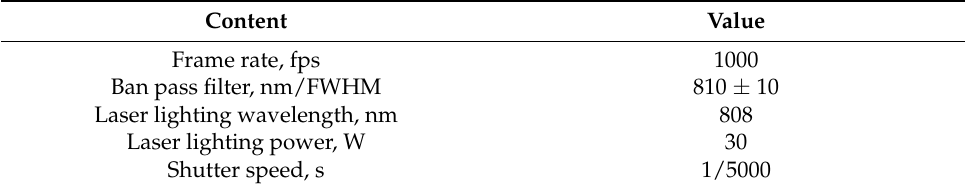
Table 3. Imaging conditions.